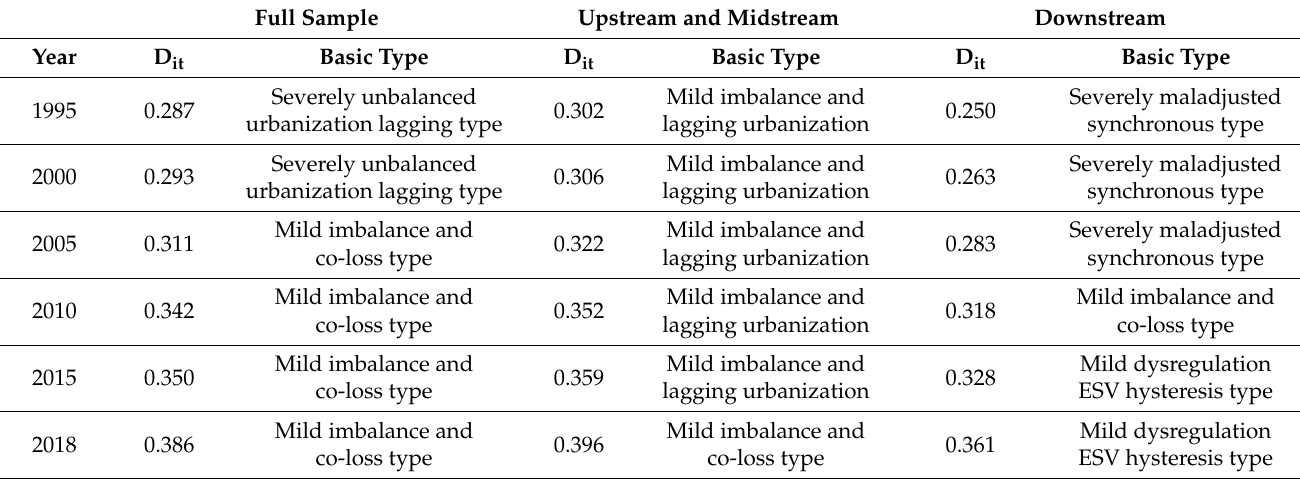
Table 5. Yellow River Basin City ESV and urbanization coupling coordination